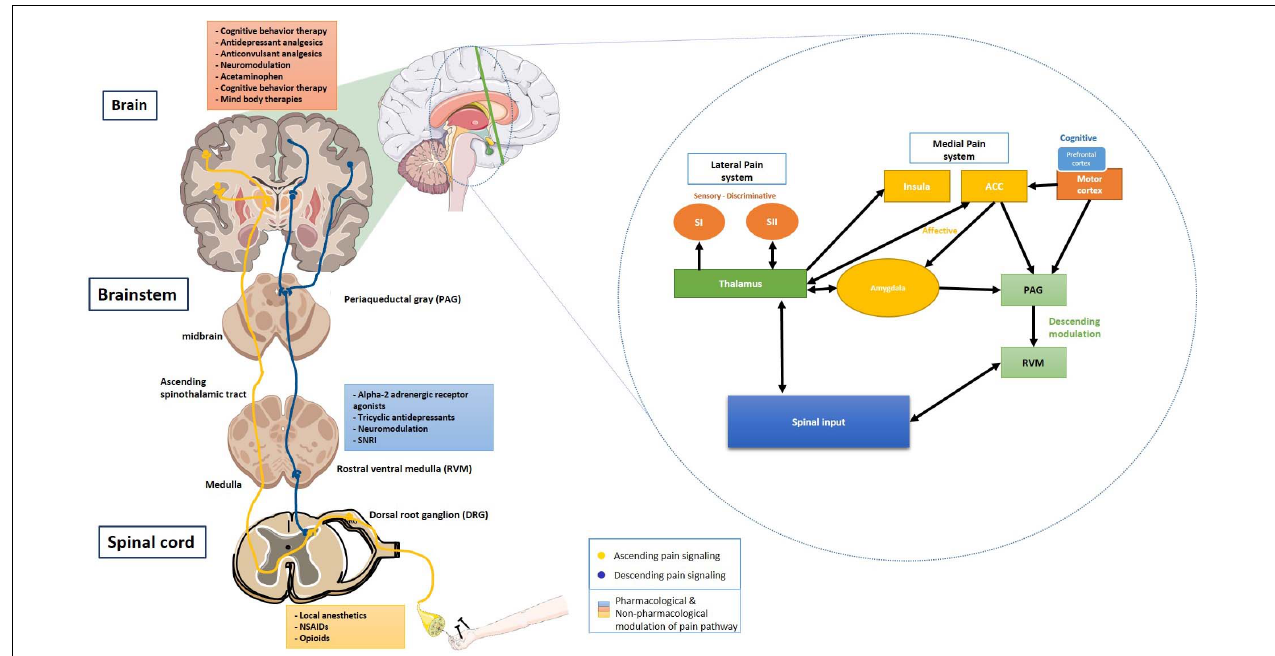
FIGURE 1 | Ascending and descending pain signaling and modulation of pain at each level. Inset shows a schematic of cortical modulation of pain. PAG, Periaqueductal gray; RVM, Rostral ventral medulla; DRG, Dorsal root ganglion; NSAIDs, Non-steroidal anti-inflammatory drugs; SNRI, Serotonin and norepinephrine reuptake inhibitor; SI, Primary somatosensory cortex; and SII, Secondary somatosensory cortex. The schematic art pieces used in this figure were provided by Servier Medical art (http://servier.com/Powerpoint-image-bank). Servier Medical Art by Servier is licensed under a Creative Commons Attribution 3.0 Unported License. Cortical modulation schedmatic adapted from Xie et al.